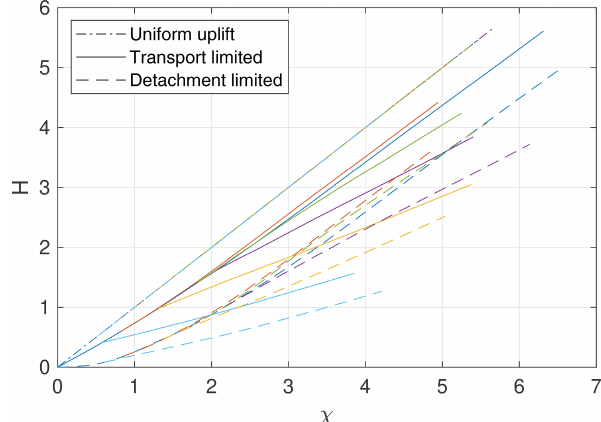
Figure 3. Swath profiles through the topographies shown in Fig. 2. The three lines of each color describe maximum, mean, and mini- mum elevation in east–west direction, i.e., over all values of x 1 .